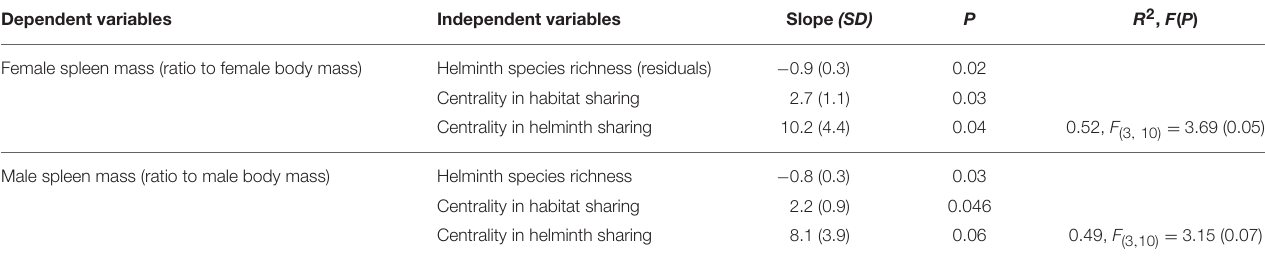
TABLE 3 | Best model explaining the relative spleen mass of female and male rodent species, expressed as ratio to body mass, using independent contrasts; initial model with helminth species richness, microparasite species richness, habitat centrality and centrality in sharing helminth parasites and centrality in sharing microparasites, using the AIC criteria (with SD = standard deviation of the